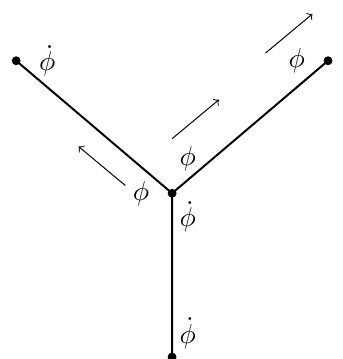
Figure 5 . Edge-labeled diagram with a choice of routing for the two φ -type half-edges attached to the central